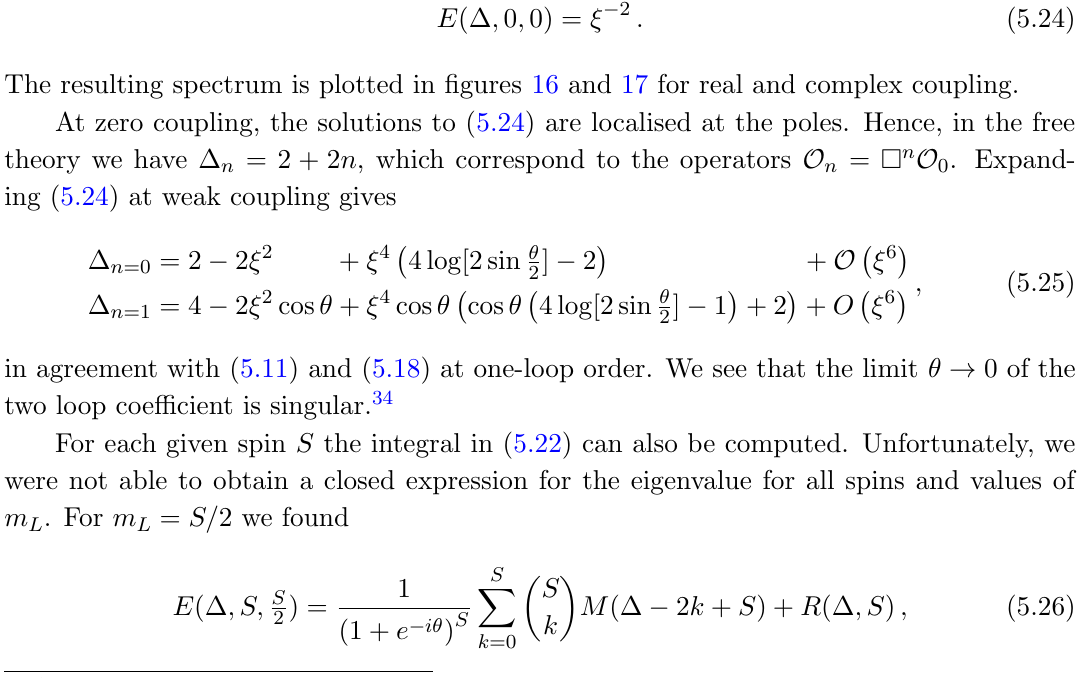
(cid:0) (cid:1) R ~(cid:18) ZX , or, equivalently, the